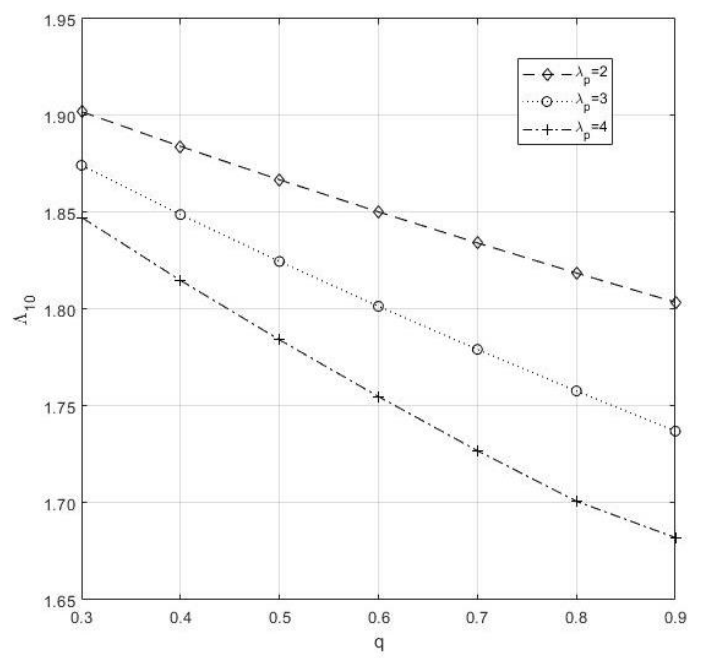
Figure 8. Mean number of Type-I Idle server of λ p vs. q .